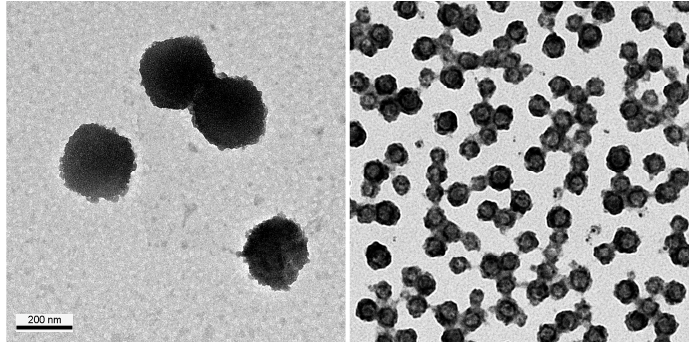
Figure 5. TEM images of PE 607 - b -PLL 275 polymeric micelles at pH = 6.2 ( left : high magnification, right : low magnification).